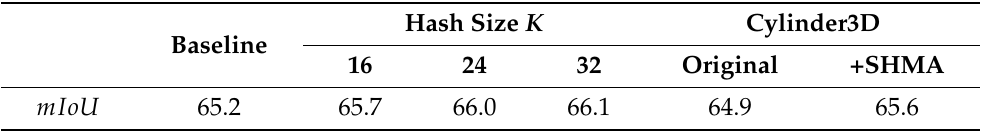
Table 4. Ablation results on the validation set of